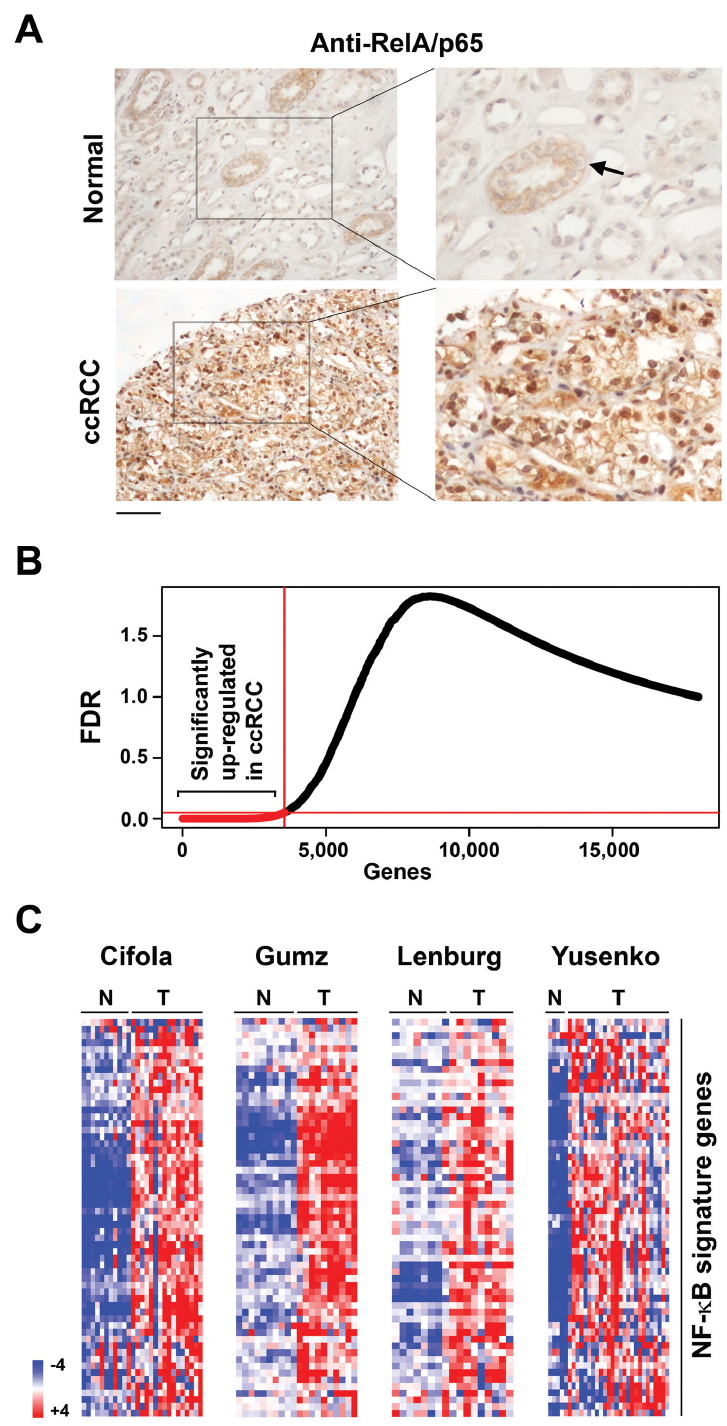
Figure 1. An NF-κB signature in ccRCC. (a) Immuno-histochemical staining showing prominent nuclear RelA signal in ccRCC samples, but not in normal kidney tissue. The arrow indicates cytoplasmic RelA staining in cells of the proximal tubular epithelium. Scale bar = 100 µM. (b) Up-regulated genes (X-axis) from the meta-analysis of the four ccRCC datasets were plotted against false- discovery rate (FDR, Y-axis). Up-regulated genes with FDR < 0.05, shown in red, were used to define NF-κB and IFN signatures. (c) Heatmaps showing expression of NF-κB signature genes in each of the four indicated studies. N = normal, T = tumor. Heat bar = expression levels (log scale). 2 doi: 10.1371/journal.pone.0076746.g001 PLOS ONE |